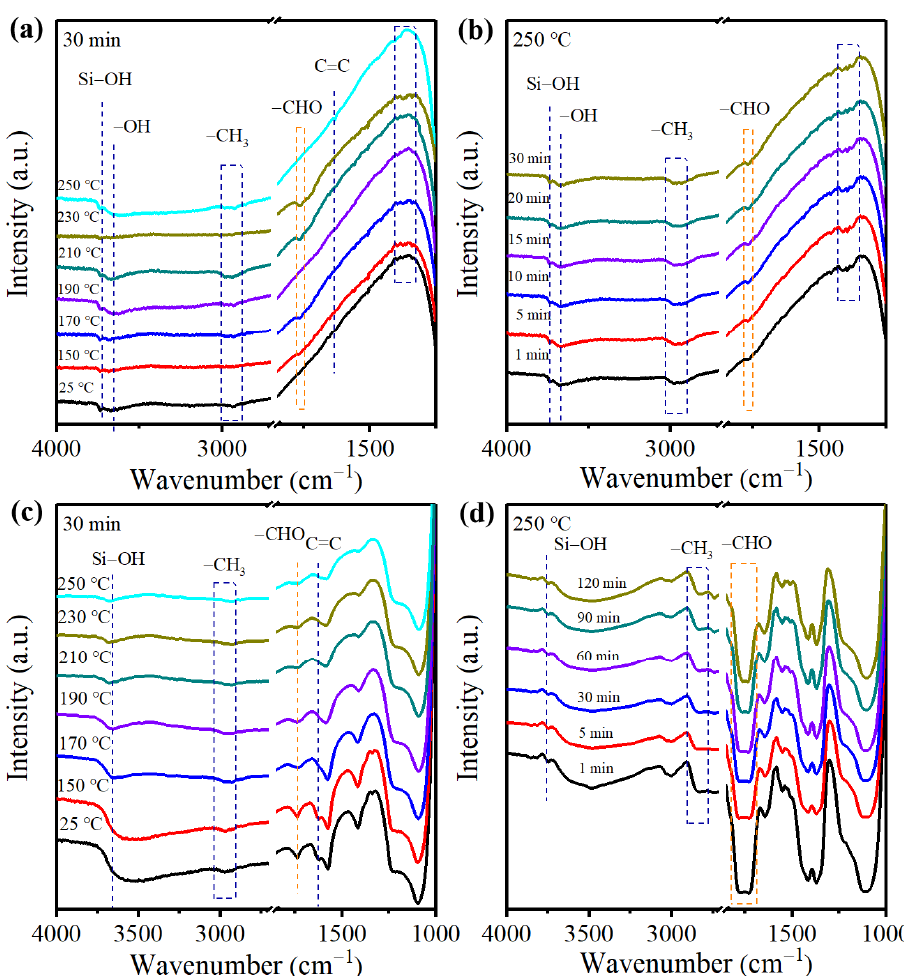
Figure 10. ( a ) In situ FTIR spectra of ethanol dehydration reaction over Cu/KIT-6 catalyst. The catalyst was exposed to ethanol atmosphere for 30 min at different temperatures followed by desorption. ( b ) In situ FTIR spectra of the catalyst exposed to ethanol atmosphere at 250 °C for different times. ( c ) In situ FTIR spectra of the catalyst exposed to acetaldehyde atmosphere for 30 min at different temperatures followed by desorption. ( d ) In situ FTIR spectra of the catalyst exposed to acetaldehyde atmosphere at 250 °C for different times.